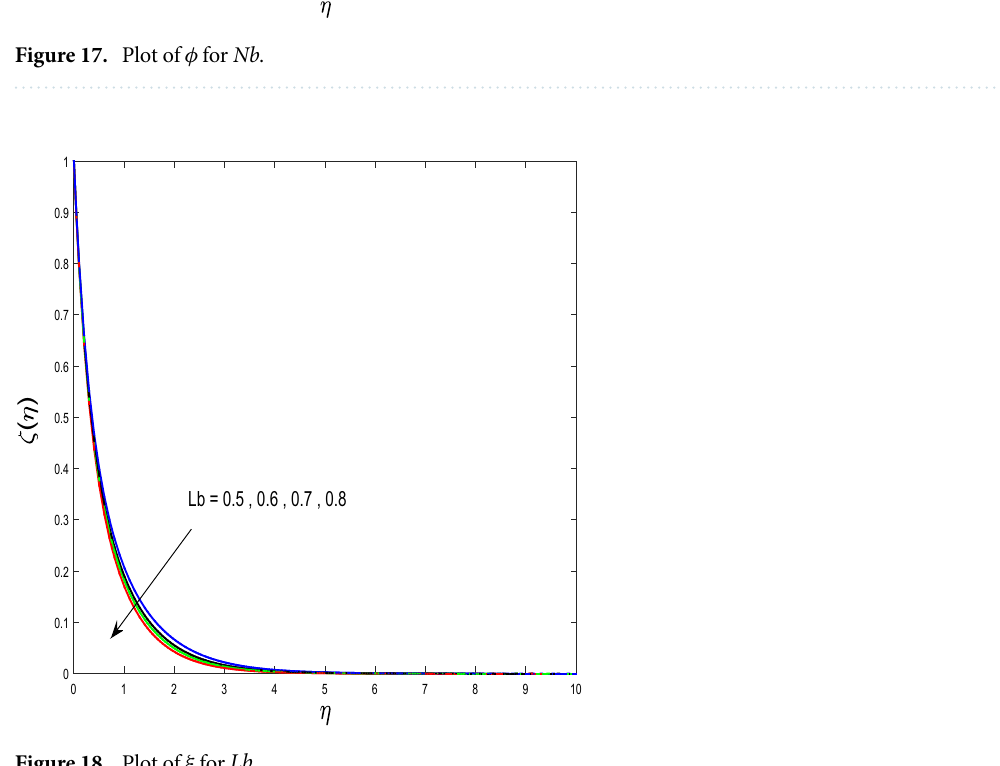
Figure 18. Plot of ξ for Lb